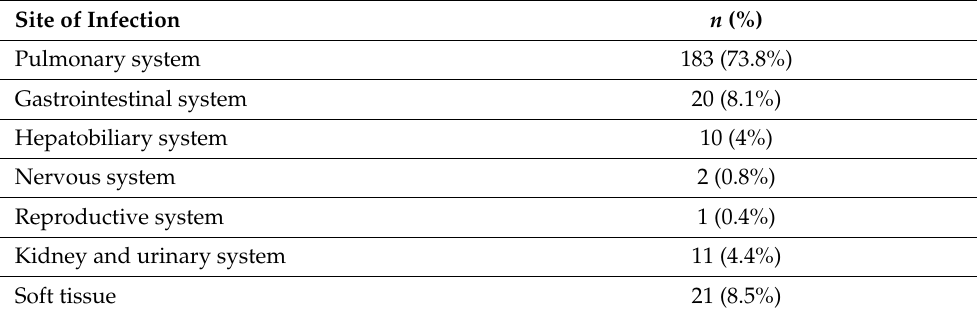
Table 2. Site of infection ( n = 248).